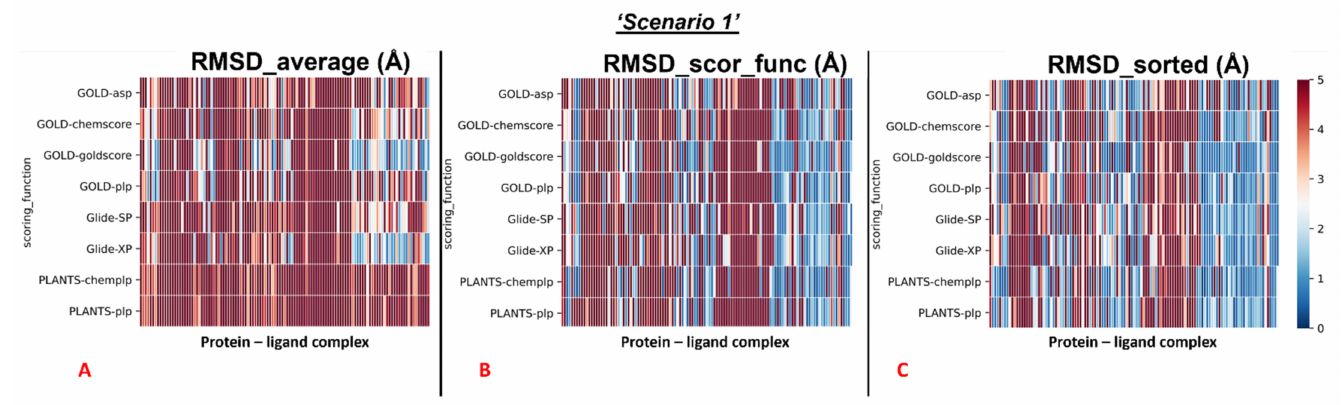
Figure 3. Colormaps represent the results of the self-docking experiments in the case in which the crystallographic water molecules are not considered during the docking runs. ( A ) Results coming from the average of the RMSDs of all the poses for each docking run. ( B ) Results derived just from the RMSD between the crystallographic ligand coordinates and the pose classified as the best from the scoring function. ( C ) Results of the self-docking experiments if just the pose showing the best RMSD value between its coordinates and the crystallographic ones are retained. The x -axis lists all the different protein–ligand complexes, which are plotted against the different pairs docking program-scoring function used for this study, reported in the y